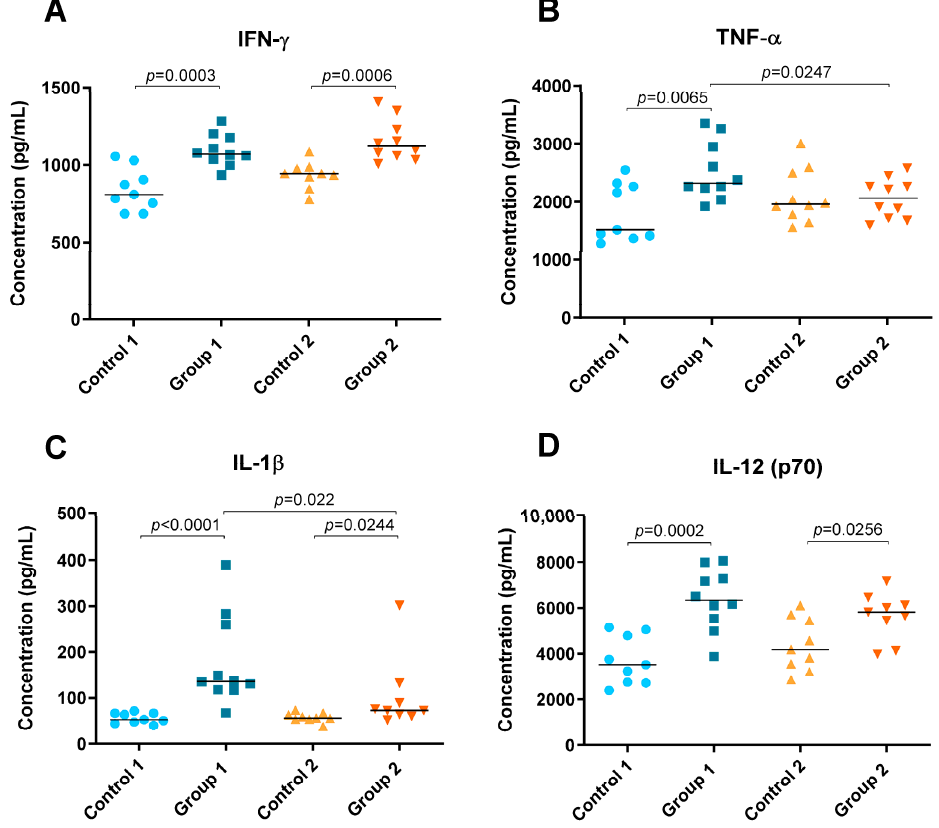
Figure 4. Th1 cytokine concentration (pg/mL) in lung tissue homogenate. In each group, data are shown as individual and median values of IFN- γ ( A ), TNF- α ( B ), IL-1 β ( C ) and IL-12 (p70) ( D ). In both groups, Groups 1 and 2, significant increases were observed in Th2 cytokines such as IL-5 ( p < 0.0001 and p = 0.0072, respectively) and IL-6 ( p = 0.0325 and p = 0.0031, respectively) but also in IL-10 ( p = 0.0002 and p = 0.0181, respectively) (Figure 5A,B,D). However, the concentration of IL-5 was higher in Group 1 than in Group 2 ( p = 0.0021) (Figure 5A). Significant differences were also observed between Group 1 and its control group for IL-13, which was higher in the group exposed to pigeon serum ( p = 0.0004) (Figure 5C). The concentration of IL-23 was higher in Group 2 than in the respective control and Group 1 ( p = 0.0009 and p = 0.0122, respectively) (Figure 5F). No significant differences were observed for IL-17A between groups (Figure